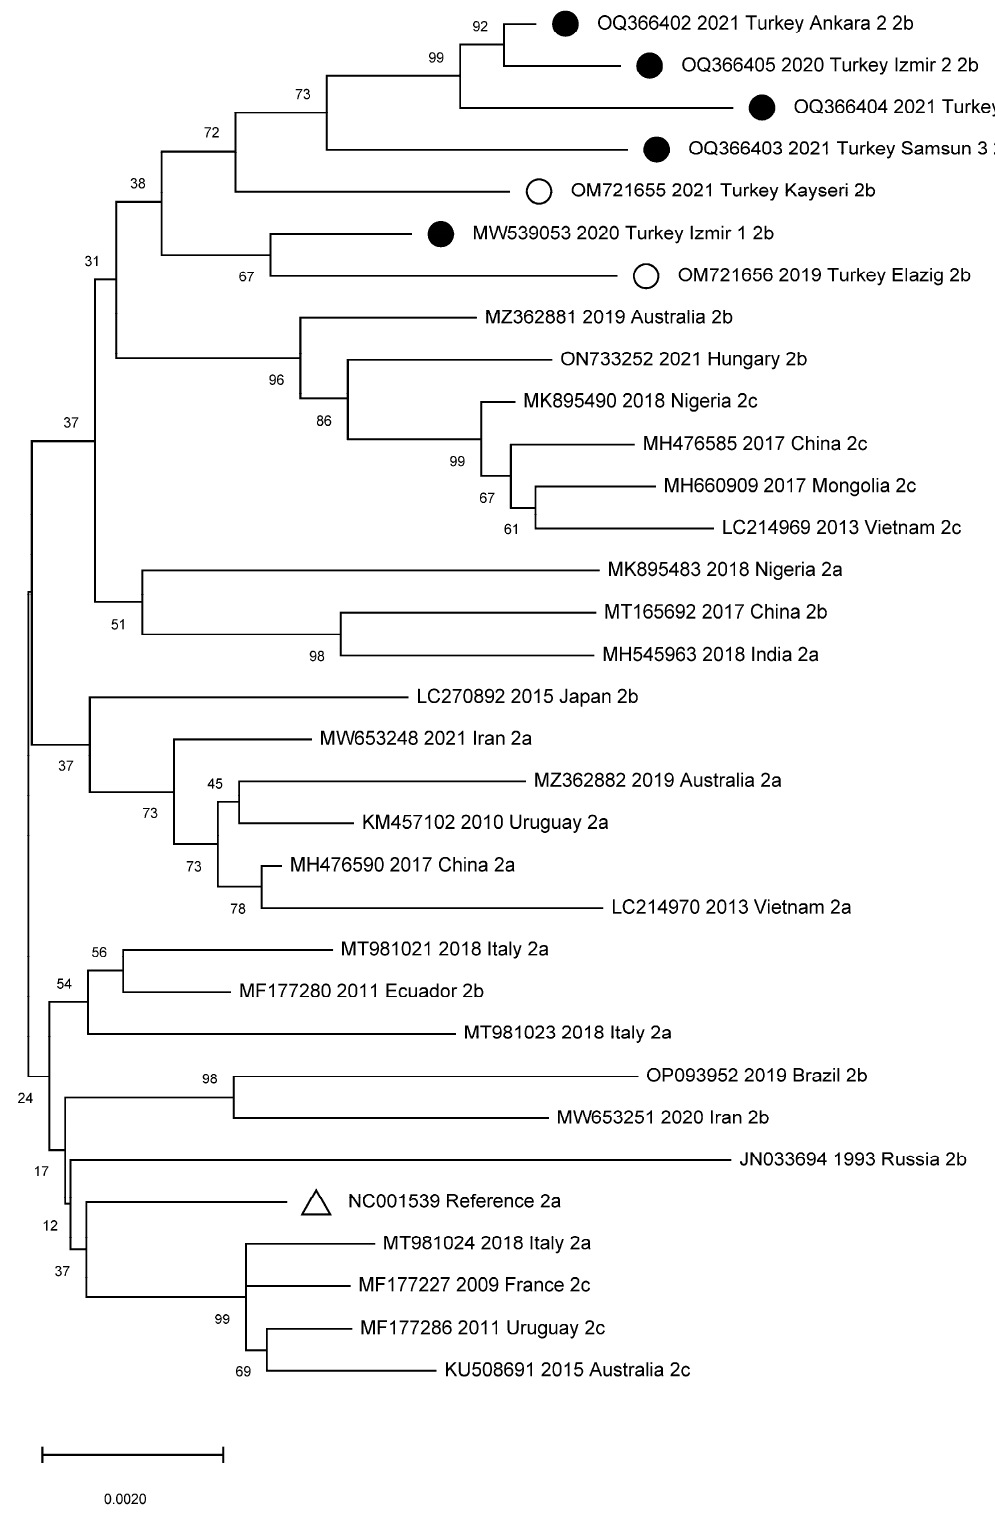
Figure 2. Phylogenetic tree based on CPV-2 genomic sequences worldwide. ● : Samples collected in this study from Turkey. ○ : Samples collected in the previous study from Turkey. ∆ : CPV reference genome.